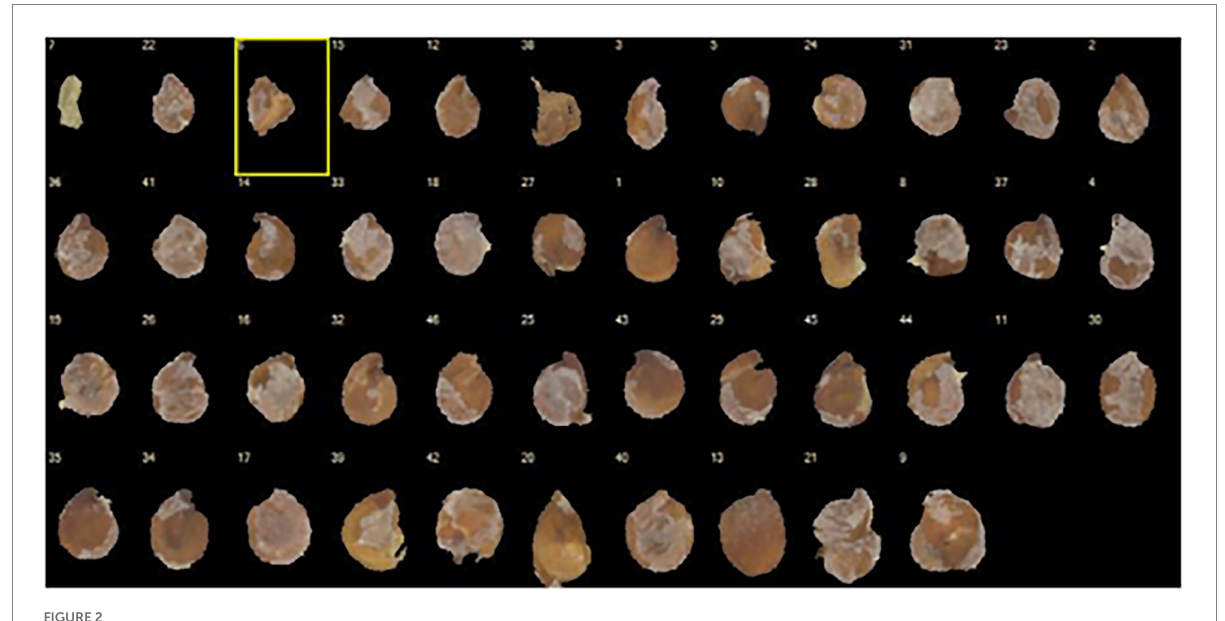
FIGURE 2 Image illustrating the large variance in seed size for A. nummularia.